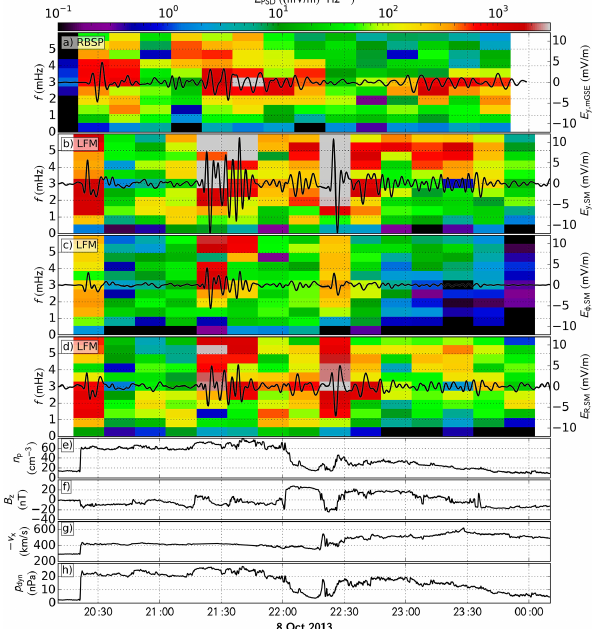
Figure 7. (a) EFW measured in mGSE (modified GSE; see Wygant et al., 2013) at RBSP B and (b) simulated (along RBSP B trajec- tory) E y , SM , (c) E φ, SM and (d) E R , SM for 4h interval including the shock impulse arrival at 20:22UT. The black line in panels (a–d) represents the electric field amplitude indicated on right. Measured solar wind input from ARTEMIS is shown in (e–h)